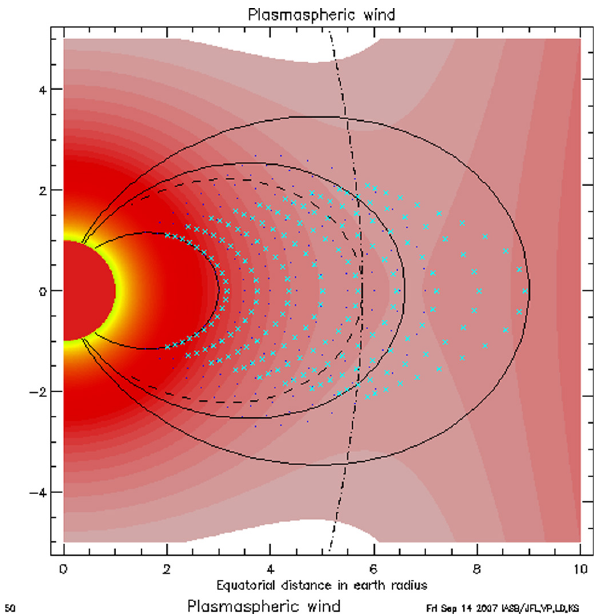
Fig. 1. Plasmaspheric wind formation simulation, as the result from a plasma interchange motion driven by an imbalance between grav- itational, centrifugal and pressure gradient forces. It shows the dis- placements of the plasma elements (the blue x symbols) from their initial positions, i.e. the black dots initially aligned along the dipole magnetic field lines which are represented by the solid lines (Pier- rard et al., 2009). Courtesy of Joseph F. Lemaire, Nicolas Andr´e and Viviane Pierrard, from a numerical simulation available at http: //plasmasphere.aeronomie.be/plasmaspherewindsimulation.htm.